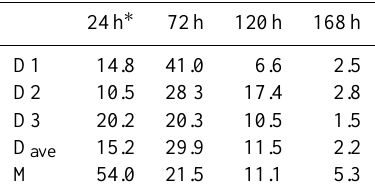
Table 7. Measured and modelled export flux of Fe (mgm − 2 d − 1 ) under dust addition. D1–D3 stand for the triplicate mesocosms with dust addition, D ave for the mean of D1–D3 and M for model results. Numbers are averaged fluxes in the time periods after dust